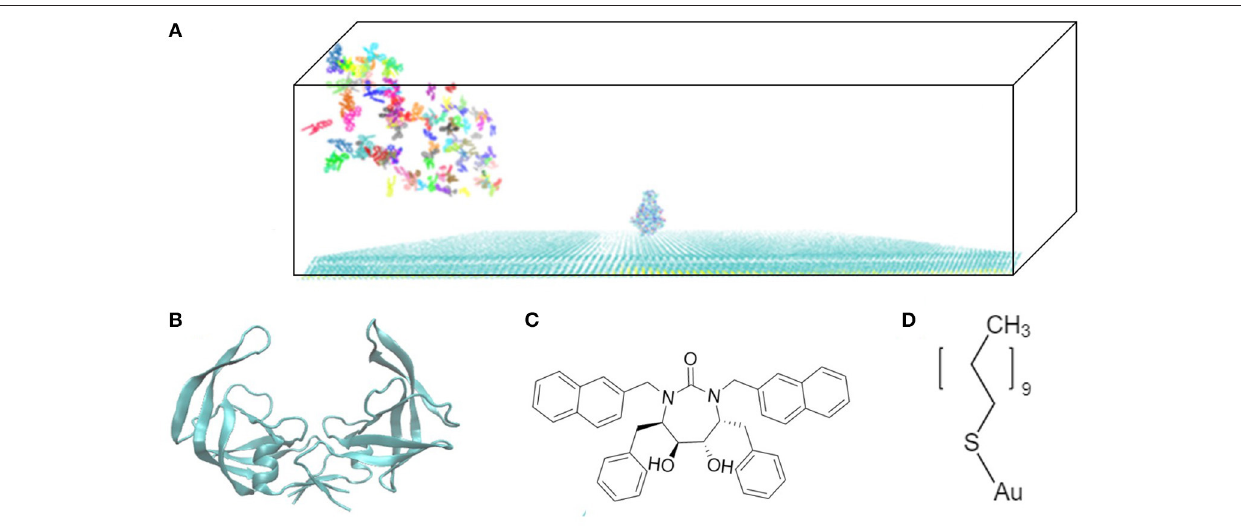
FIGURE 1 | Model system. (A) HIVp is placed at the center of the CH 3 -SAM surface with xk263 ligands in a yz-plane when a simulation starts. (B) Structure of an open-form HIVp in cartoon representation. (C) xk263 ligand, and (D) undecanethiol molecule used to build the SAM surface. Notably, in each BD run, the molecular system has only one xk263 and one HIVp. To speed up the calculations, multiple replicas of xk263 are simulated simultaneously, but the replicas do not interact with each other.